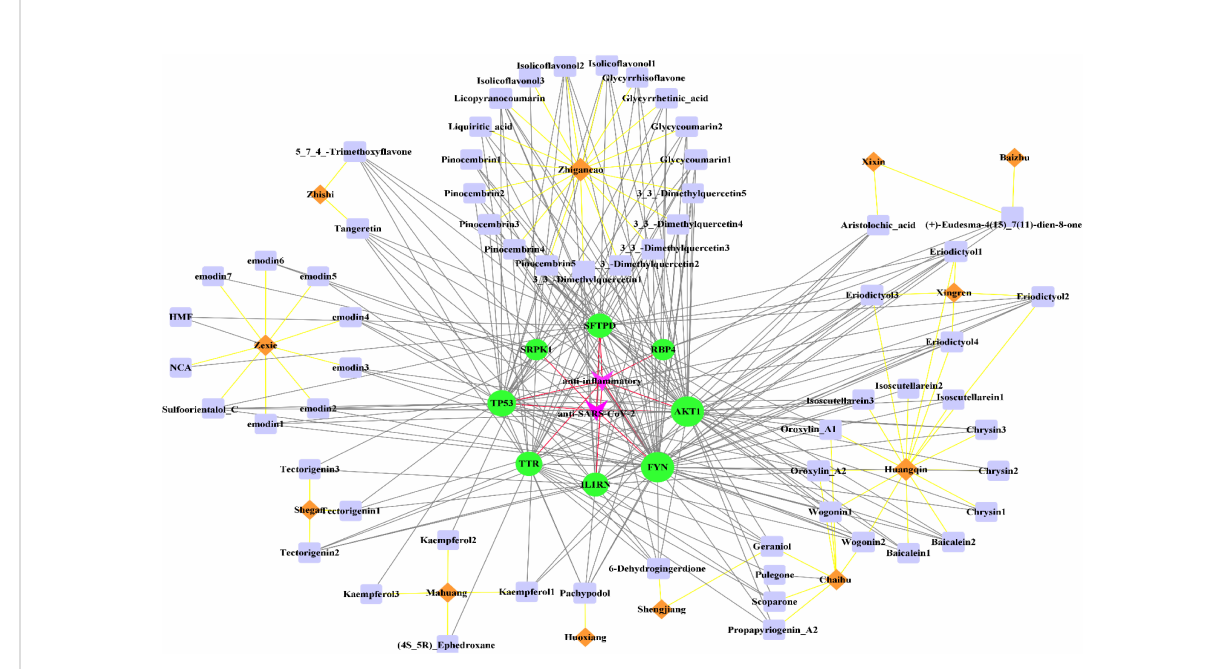
FIGURE 4 The “ herb-active component-target ” interaction network diagram for the treatment of COVID-19. 12 herbs (Mahuang, Zhishi, Huoxiang, Zexie, Shegan, Shengjiang, Chaihu, Huangqin, Xingren, Baizhu, Xixin, Zhigancao) in QFPD are marked in orange; 62 active components screened from 12 herbs with anti-SARS-CoV-2 or anti-in fl ammatory effects are marked in purple; 8 potential targets of QFPD are marked in green, and the properties of the targets are marked in pink. The black line represents that a certain active component comes from a certain herb; the yellow line represents the interaction between the active component and the target, and the red line represents a certain target is against in fl ammation or